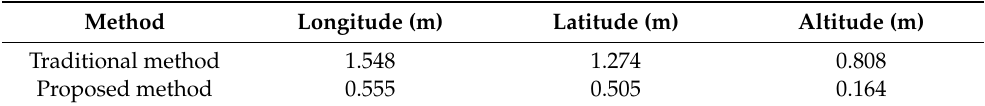
Table 2. Comparison of the RMSE of the follower UAV’s positioning error by using traditional CP method and the proposed method.